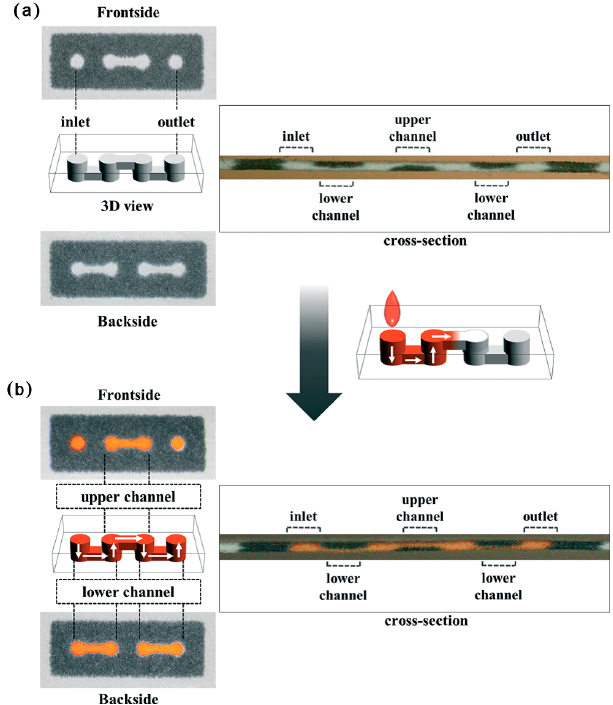
Figure 7. Scheme of the 3D- µ PAD formation on a single sheet of paper in [116]. Before ( a ) and after ( b ) loading the red dye solution, the front, backside and cross section images of each parts indicated that the red dye solution had smoothly flowed from the inlet to the outlet via the alternative lower and upper channels. With the permission from [116]; Copyright 2015, The Royal Society of Chemistry.